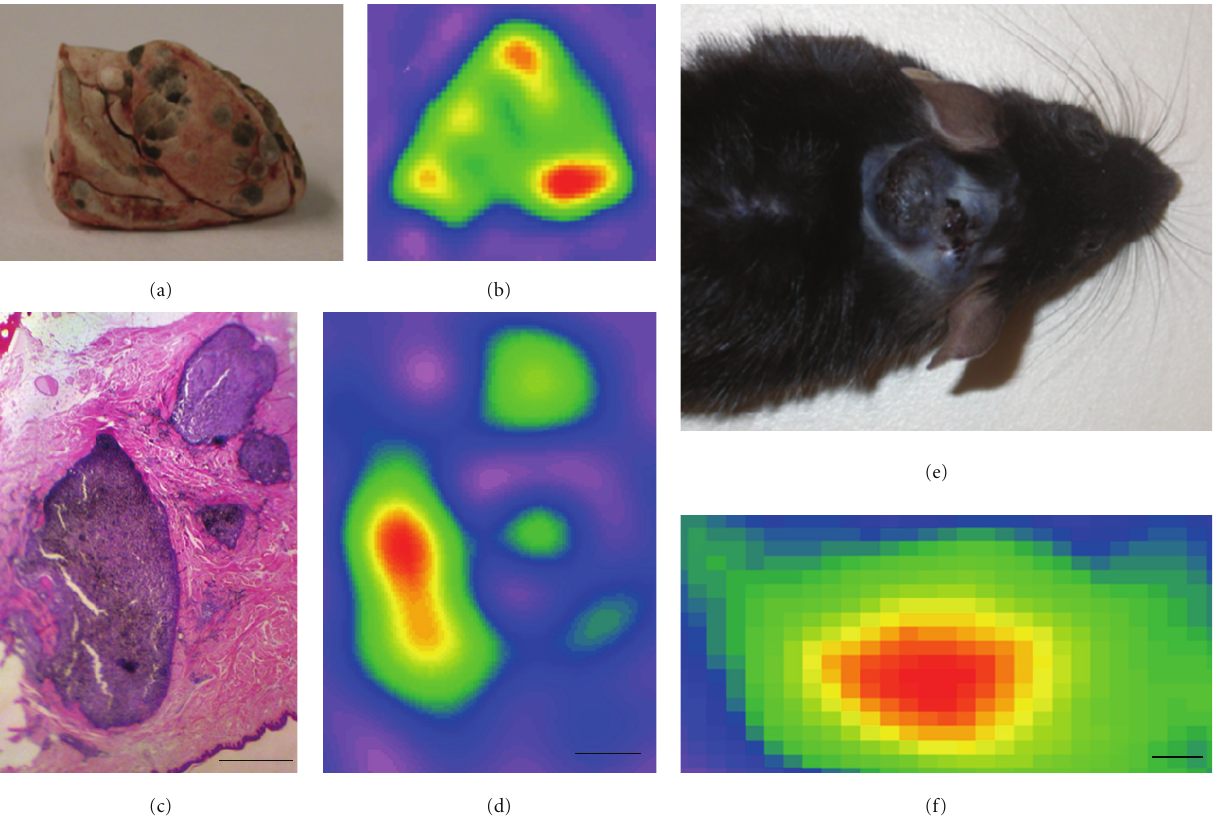
Figure 3: (a, b) Melanoma B16 metastases in the lungs of mice: picture of freeze-dried lungs with metastases (a) and the respective 2D transversal EPR image (b). (c, d) 2D EPR image through a section of thickness 500 mm of a para ffi n-embedded human melanoma (d) and the histological section (5mm thick) from a contiguous slice (c). Scale bars: 1mm. (e, f) In vivo studies on B16 melanoma in mice. Melanoma grown in subcutaneous tissue (e) and in vivo EPR image obtained using a low-frequency EPR spectrometer with a head-coil loop-gap resonator. Scale bar: 2 mm. Pictures coming from Vanea et al.